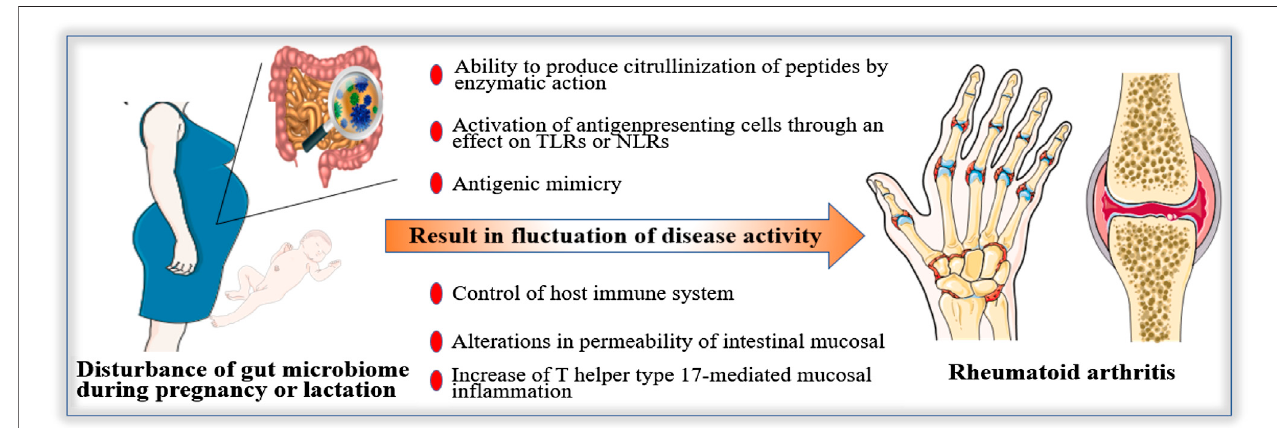
FIGURE 2 | Possible mechanisms of gut microbiome in Rheumatoid arthritis (RA) during pregnancy and lactation. The fl uctuation of disease activity of RA during pregnancy and lactation may be affected by gut microbiome. The possible mechanisms are as follows: 1) The ability to produce citrullinization of peptides by enzymatic action. 2) Activation of antigenpresenting cells through an effect on Toll-like receptors or Nod-like receptors. 3) Antigenic mimicry 4) Control of host immune system (triggering T cell differentiation). 5) Alterations in permeability of intestinal mucosal. 6) Increase of T helper type 17-mediated mucosal in fl